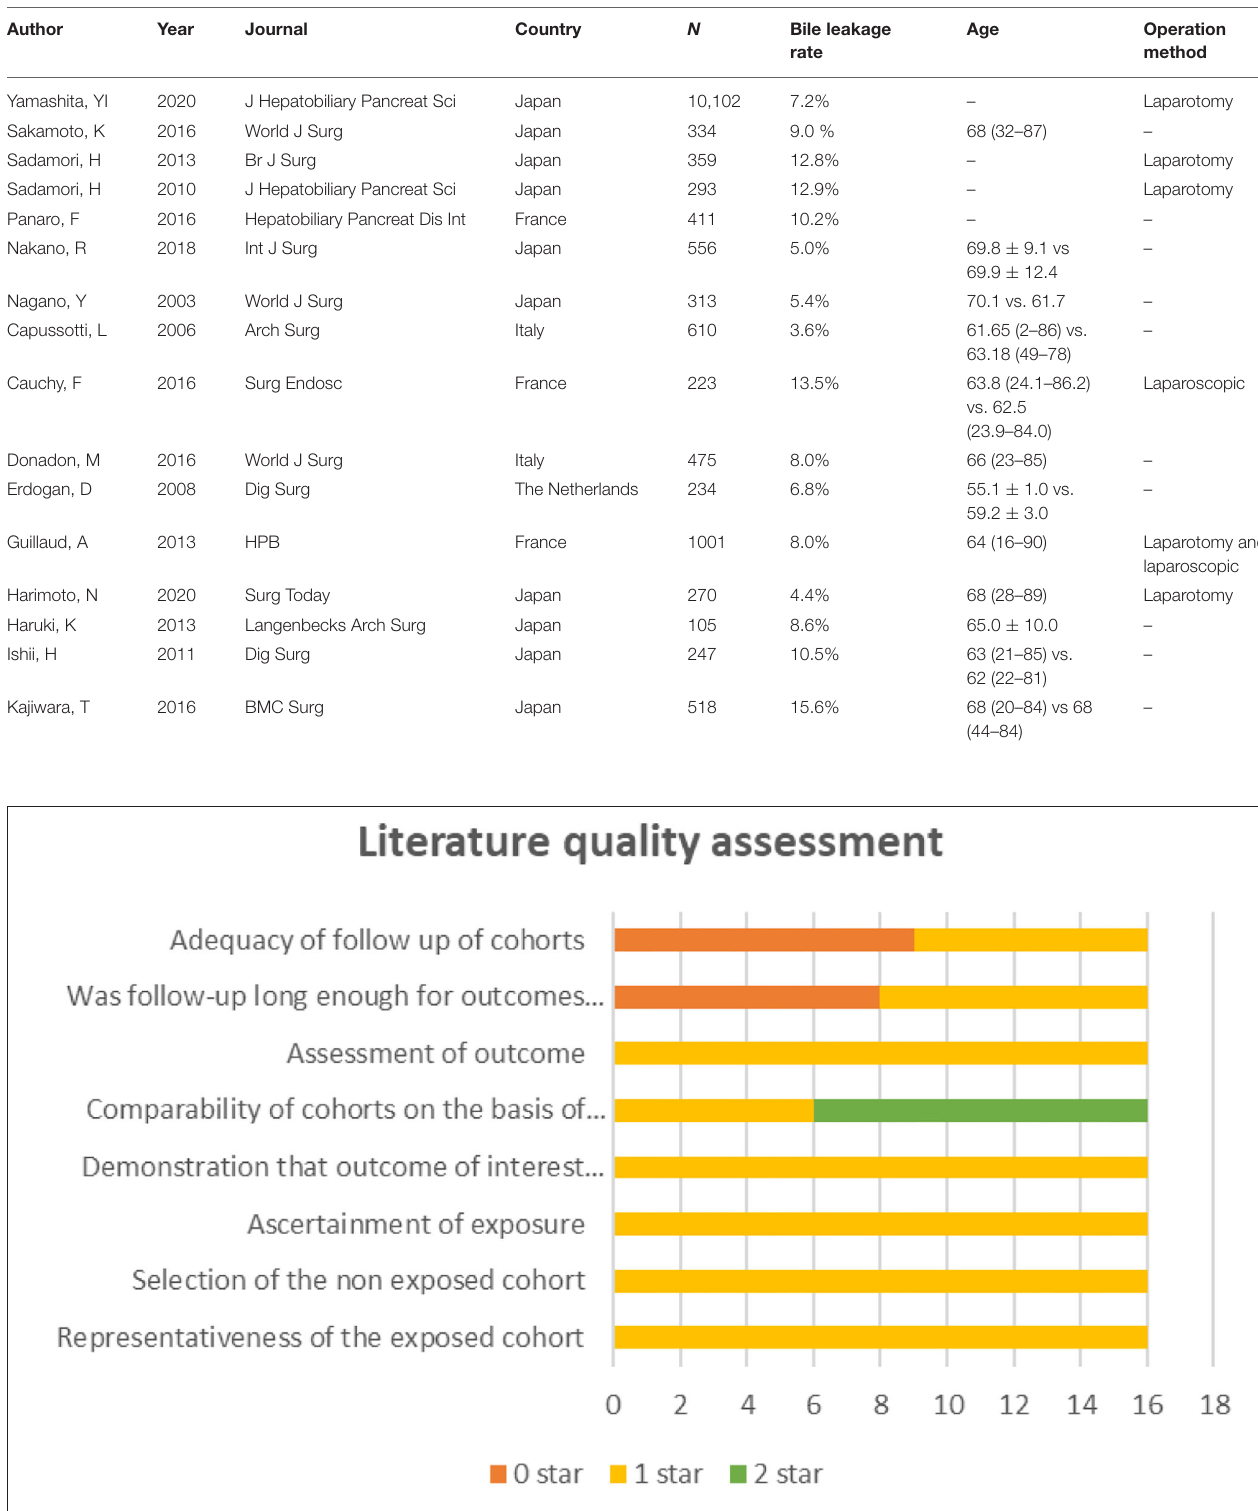
FIGURE 2 | Literature quality assessment based on the Newcastle-Ottawa Scale.